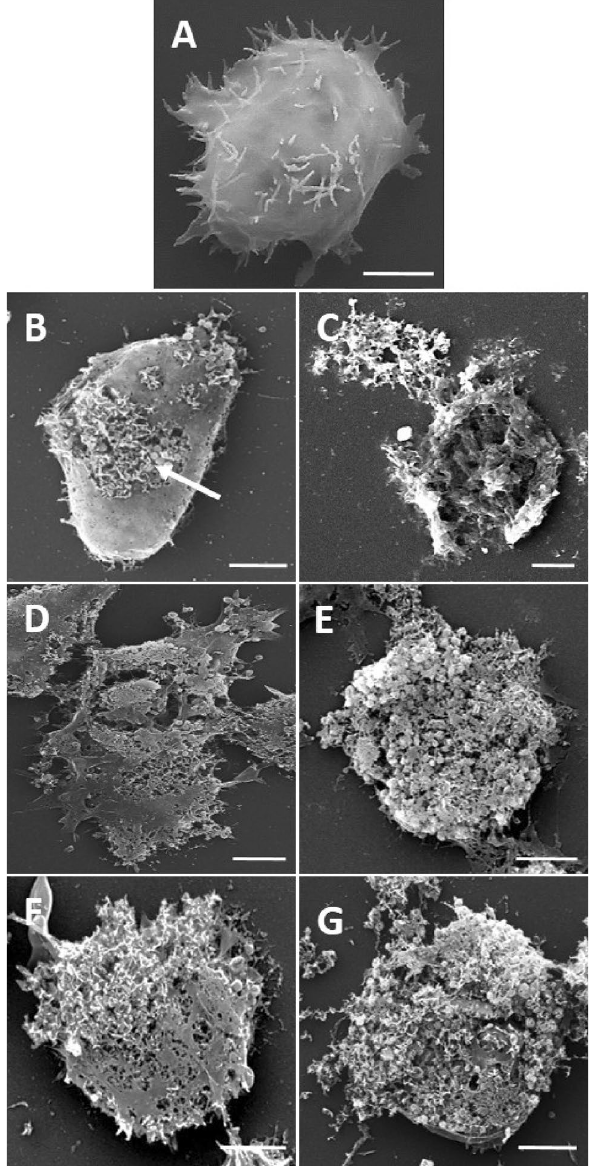
of CLX after 24 h, ( E ) 1 mg/L of CLX after 48 h, F) 2 mg/L of ArCO 2 G2(SNMe 3 I) 4 ( 2 ) and 0.5 mg/L of CLX after 24 h, ( G ) 2 mg/L of ArCO 2 G2(SNMe 3 I) 4 ( 2 ) and 0.5 mg/L of CLX after 48 h. Scale bars = 5